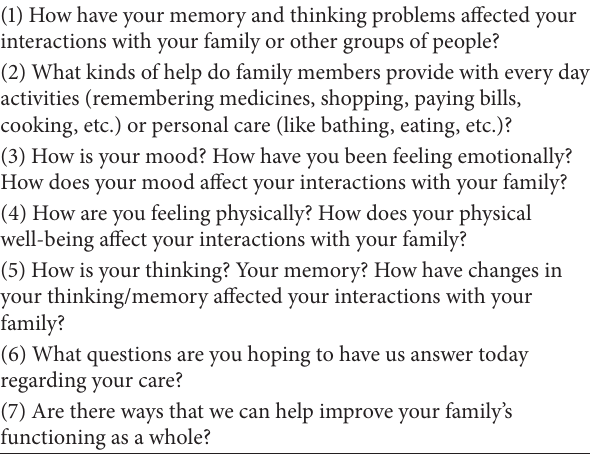
Table 1: Study questions (worded differently for the patient versus caregiver versions).